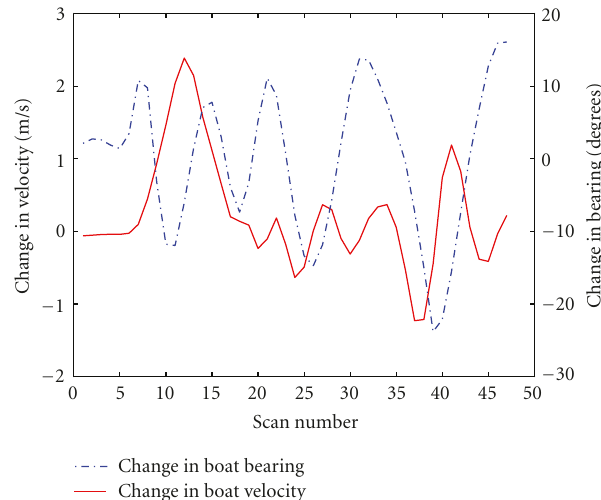
Figure 5: Change of velocity and bearing of boat between scans of trial collection